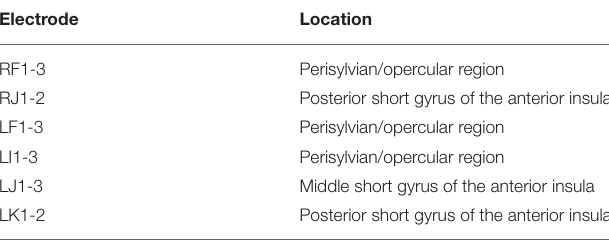
TABLE 1 | Location of electrodes of interest.